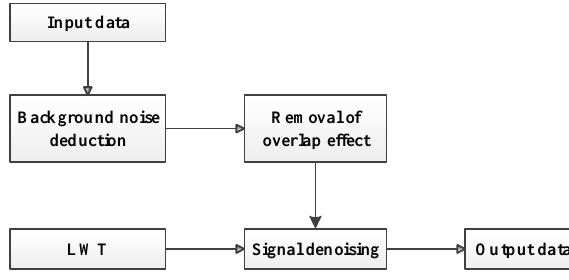
Figure 9. Flowchart of lidar signal denoising via LWT.